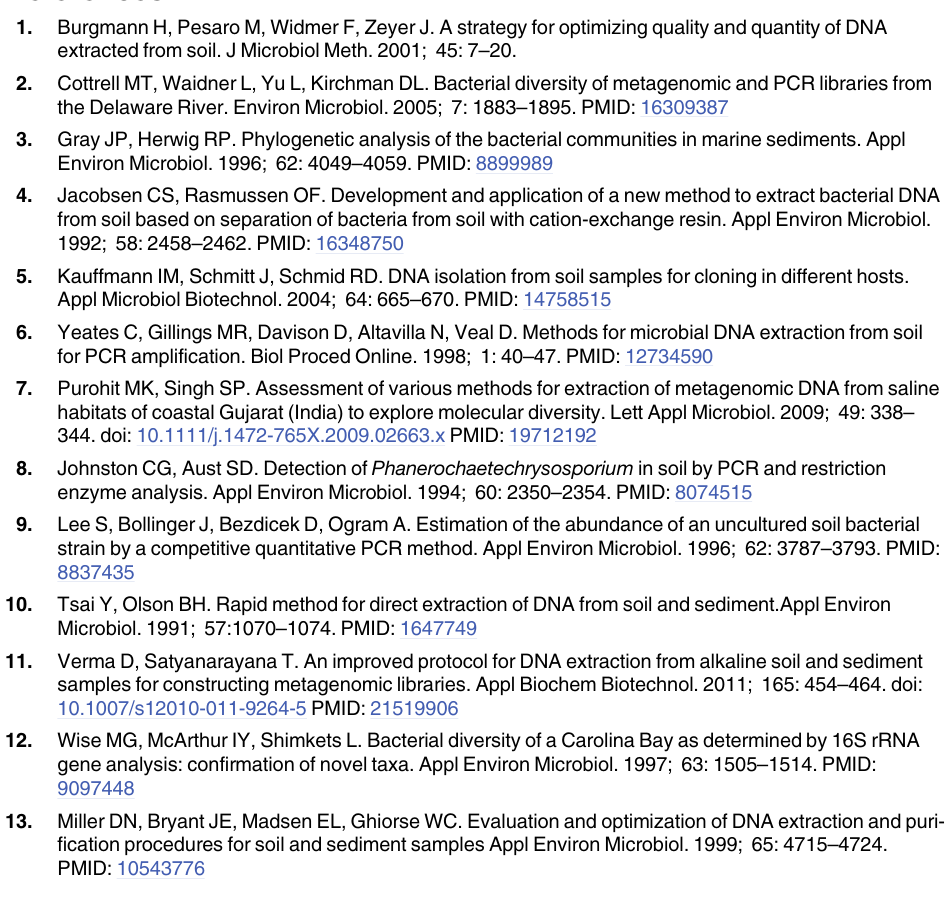
S4 Table. Triplicate values for A S5 Table. Triplicate values for A S6 Table. Triplicate values for DNA yield ( μ g/g of soil) for method M2 and its modifica-